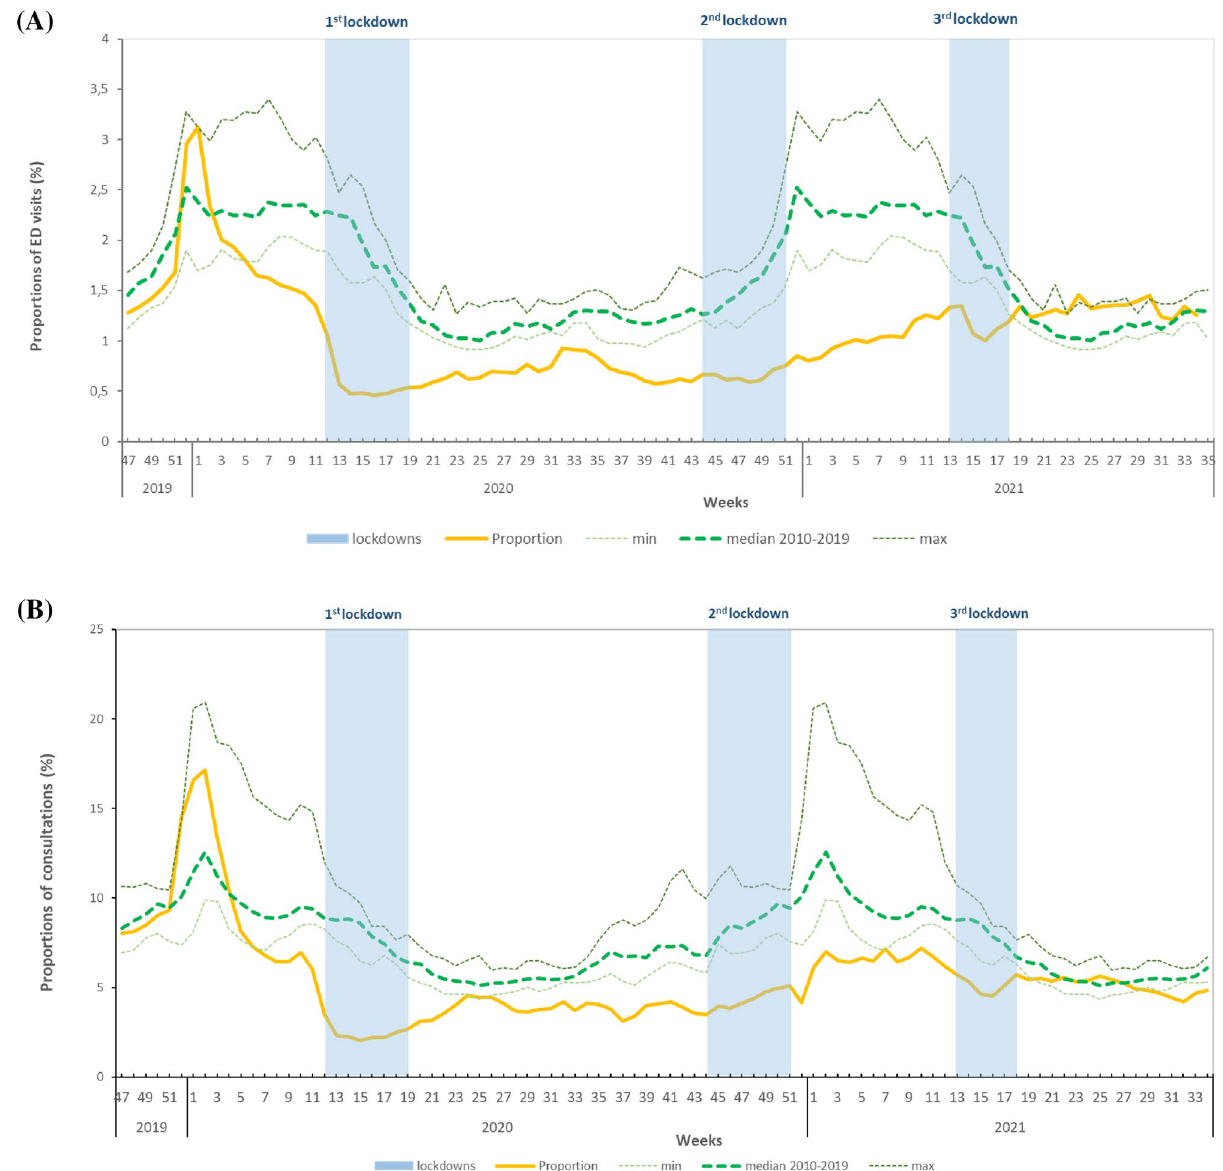
Figure 1. Weekly proportion of consultations for acute gastroenteritis, November 2019–August 2021 (yellow line), in ( A ) emergency departments (OSCOUR), ( B ) GP emergency house-calls (SOS Médecins), and ( C